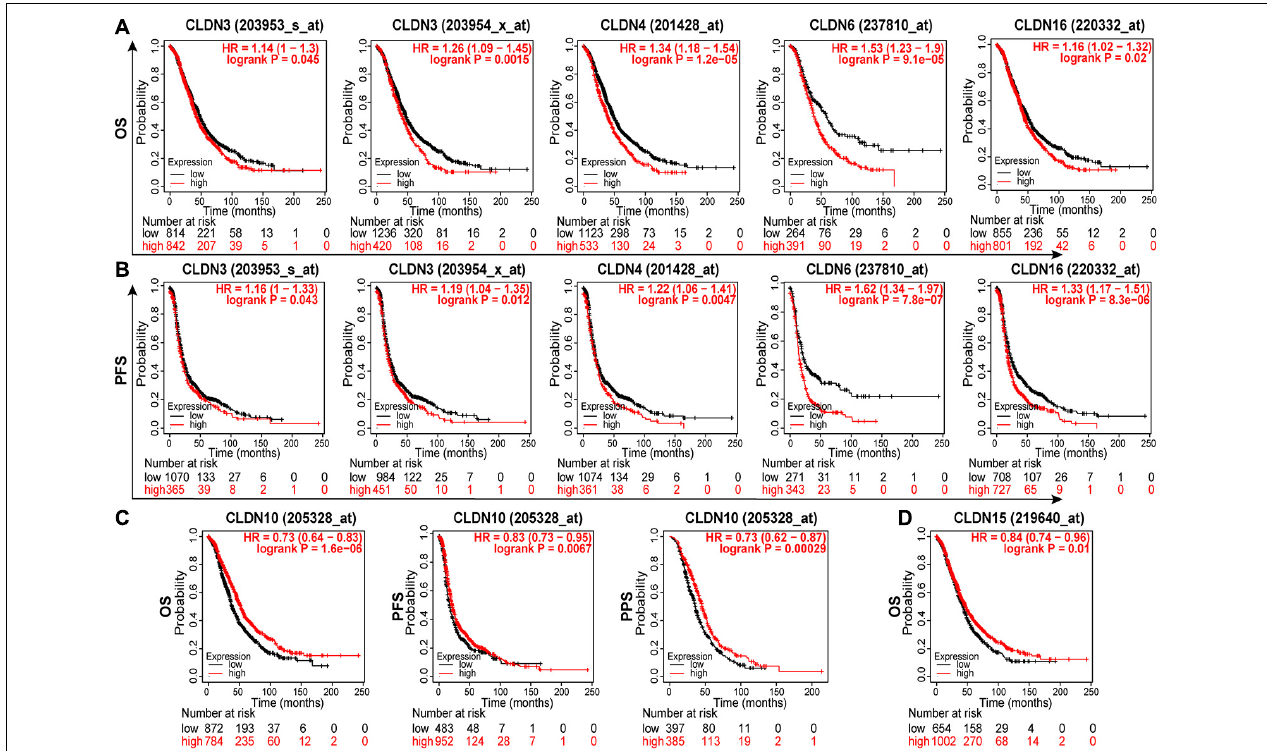
FIGURE 3 | The relationship between claudin expression and the prognosis of ovarian cancer patients through Kaplan-Meier plotter. The overexpression of CLDN3, CLDN4, CLDN6, and CLDN16 were significantly correlated with poor OS (A) and PFS (B) . (C) The overexpression of CLDN10 predicted good OS, PFS, and PPS. (D) The low expression of CLDN15 predicted poor OS in ovarian cancer. OS, overall survival; PFS, progression free survival; PPS, post progression